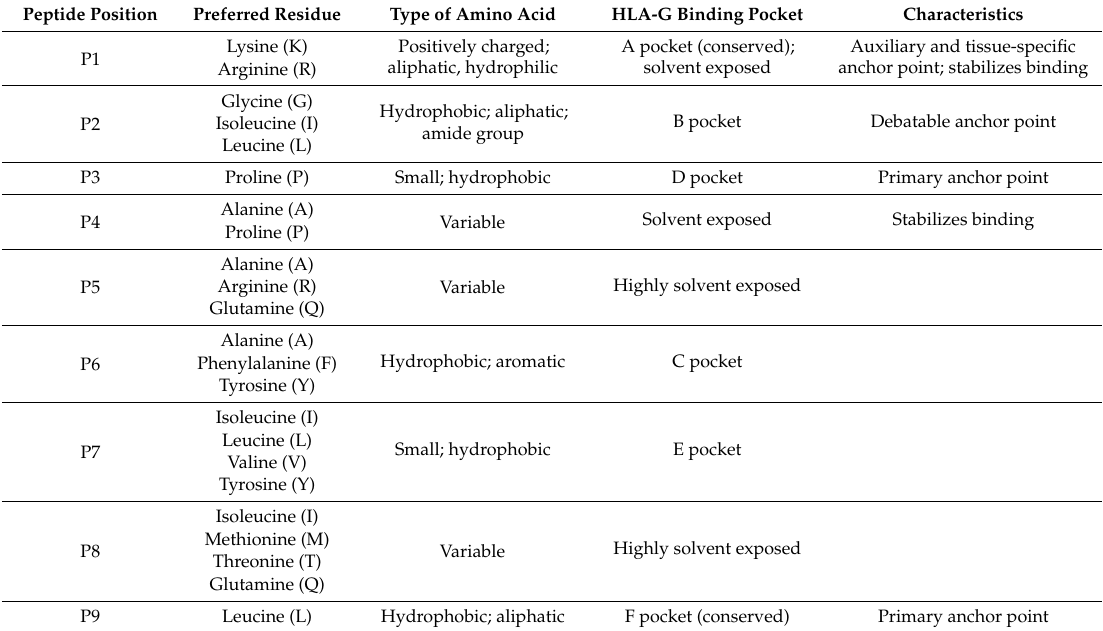
Table 1. Primary structure and characteristics of peptides presented by HLA-G1. Each peptide position has a preference for certain amino acids and is either located in a binding pocket (A-F, further explained in Figure 2) in the peptide binding groove of HLA-G1, or is solvent